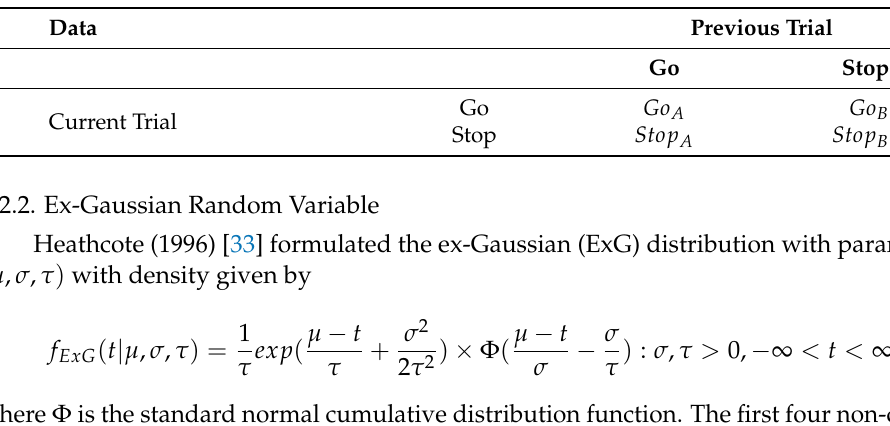
Table 1. Partition of stop task (SST) data to Type A SST data and Type B SST data given previous trial type (go/stop)